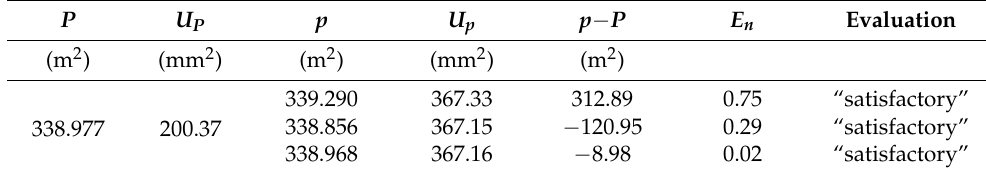
Table 7. Number E n , for polygon area ( i = AGROS; “Vekom Net”;